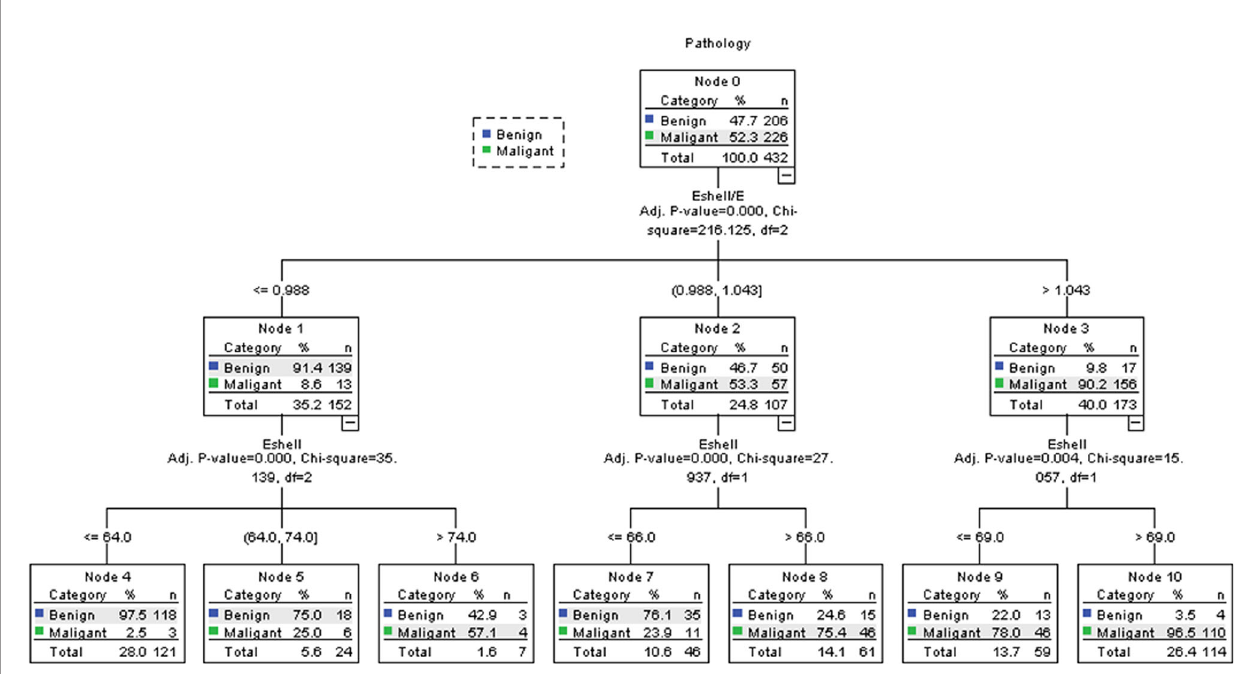
FIGURE 6 | Decision tree of the CHAID. Using the parameters with the highest discriminating power ( E shell and E shell / E ), the research population (Node 0) was further split into child nodes (1 – 10). After two rami fi cations, no further discrimination could be achieved. Green tags indicate the percentage of malignant TNs, while blue tags indicate the percentage of benign TNs in each node.